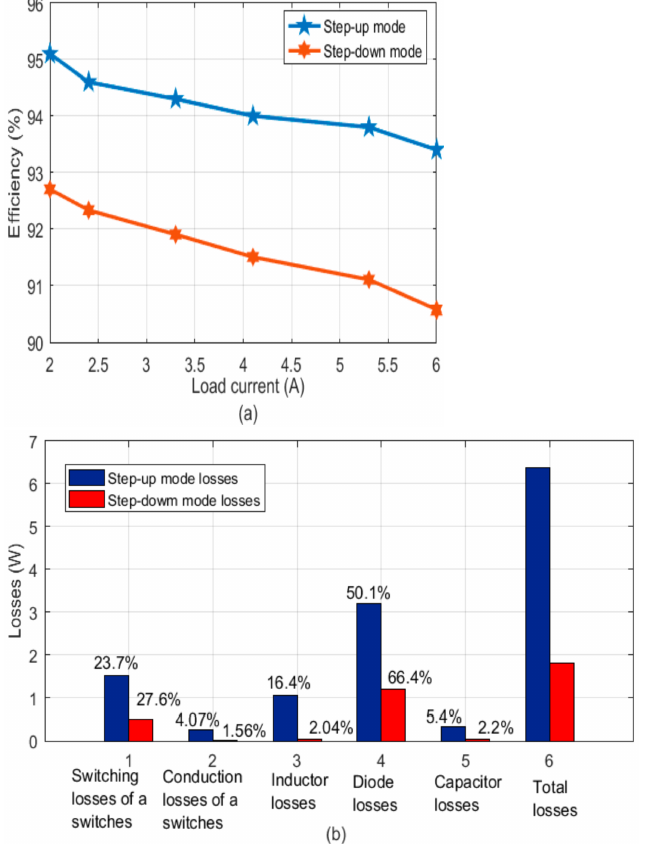
Figure 11. Efficiency and loss distributions. ( a ) Efficiency curve and ( b ) losses distributions under V 0 = 72 v, P 0 = 173